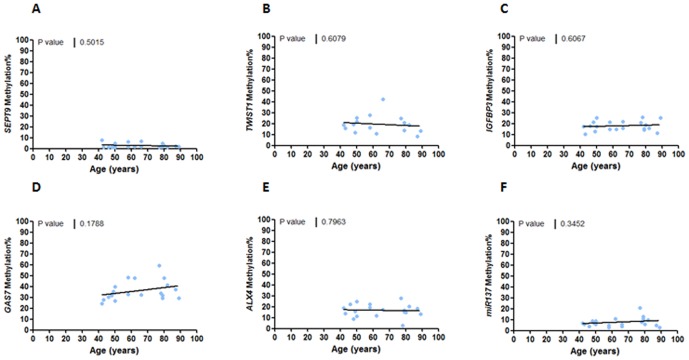
Correlation between colon mucosa methylation and age of healthy controls. linear regression analysis comparing tumor methylation of sept9 (a), twist1 (b), igfbp3 (c), alx4 (d), gas7 (e) and mir137 (f) vs age of the healthy control patients (years).